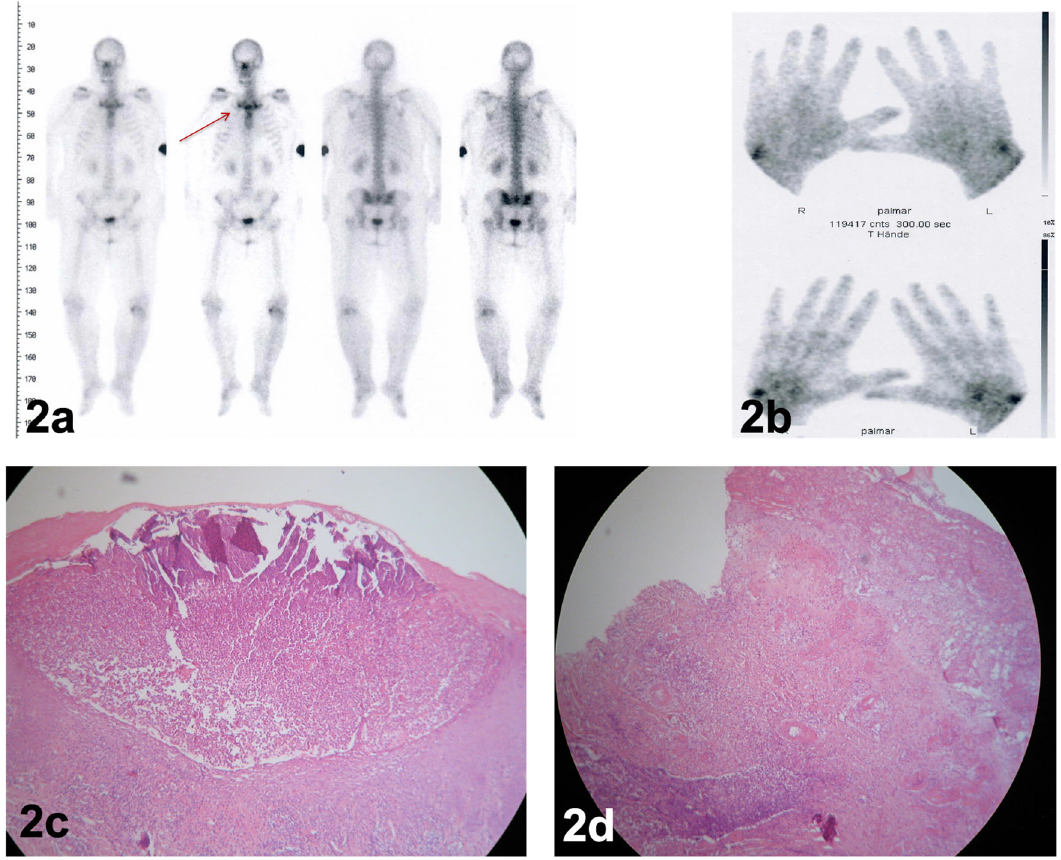
Figure 2. Bone scan revealing a “ bull ’ s head ” sign-like radiopharmaceutical accumulation of the costoclavi- cular region (2a, red arrow) and of the wrist joints (2b). (2c): histopathologic evaluation of palmar pustular eruptions revealed characteristic microabscesses of subcorneal neutrophilic accumulation. (2d): Histology of the lower-leg ulcerations demonstrated diffuse neutrophilic inflammation as a hallmark of pyoderma